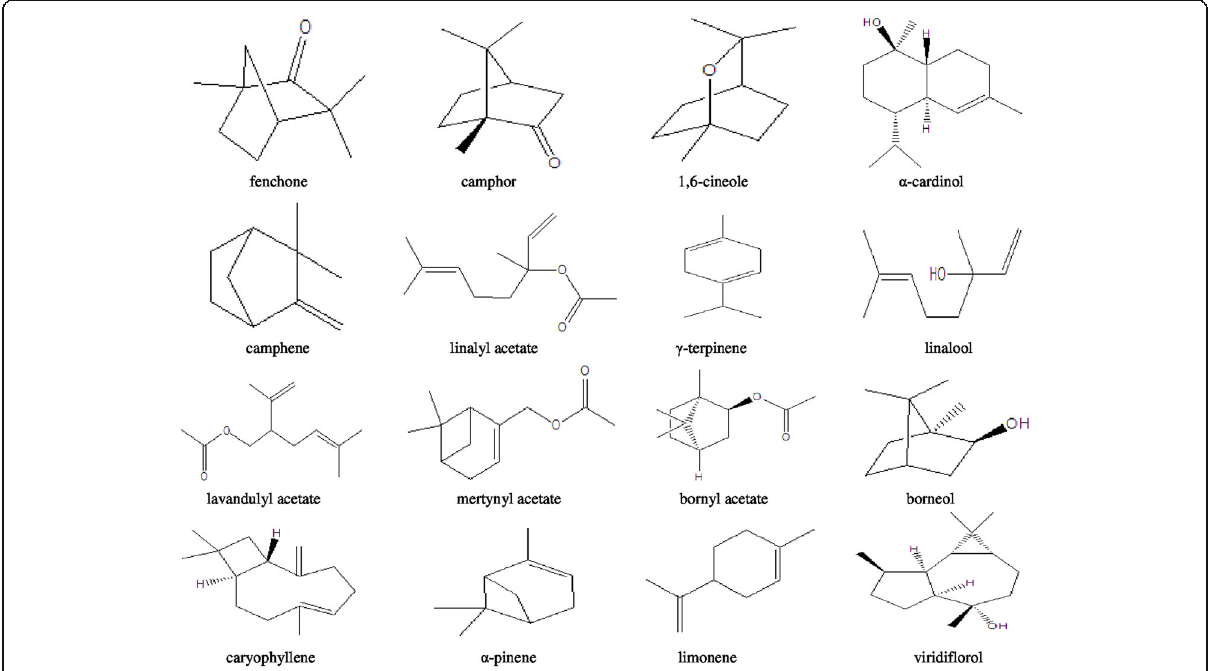
Fig. 3 Chemical structures of major compounds in L.stoechas essential